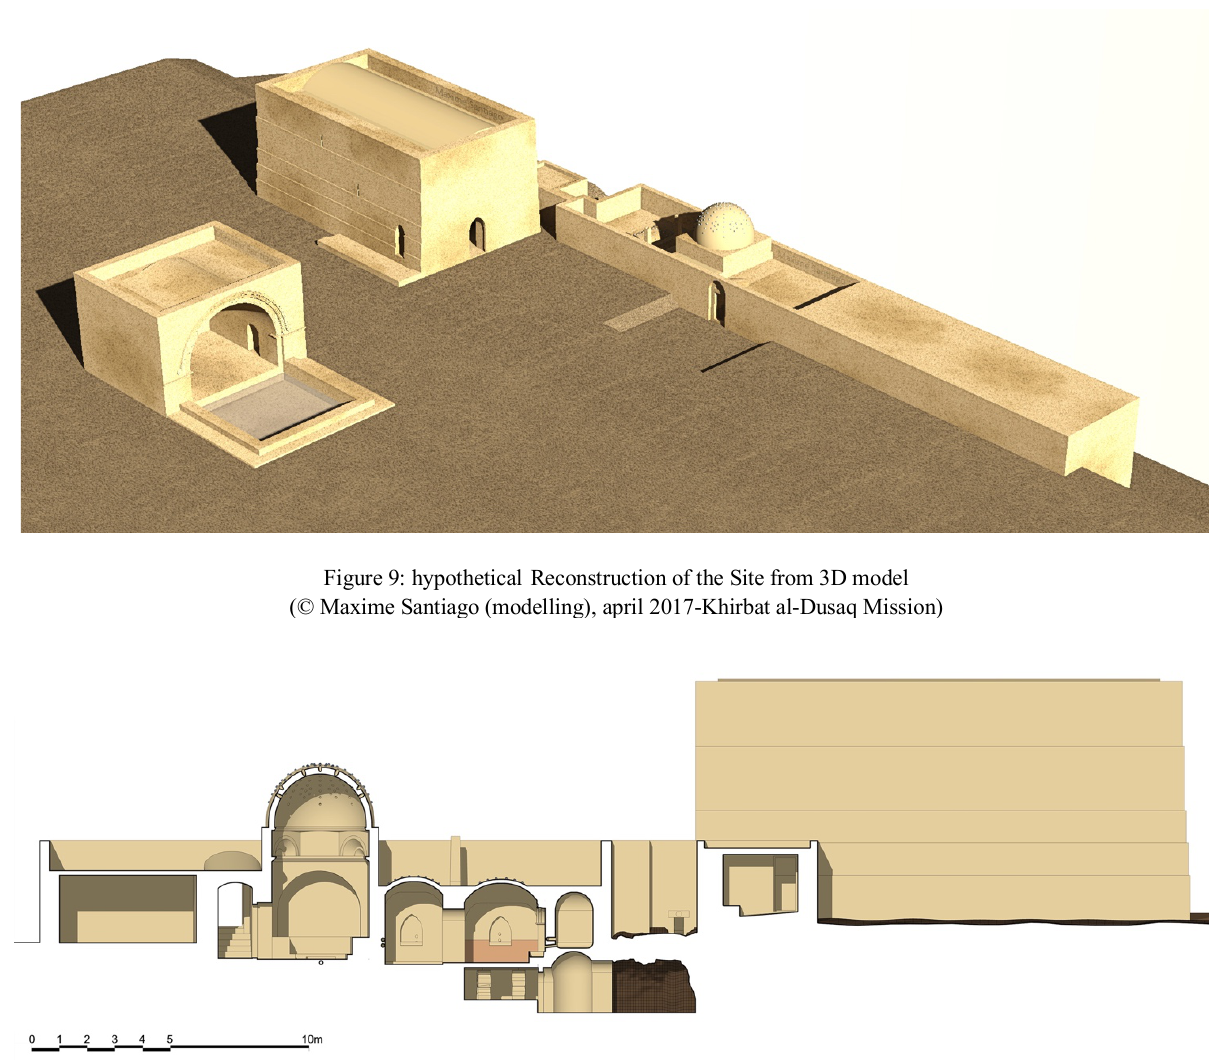
Figure 10: hypothetical reconstruction, section E-W from 3D model of bath (building C) (© Maxime Santiago (modelling), april 2017-Khirbat al-Dusaq